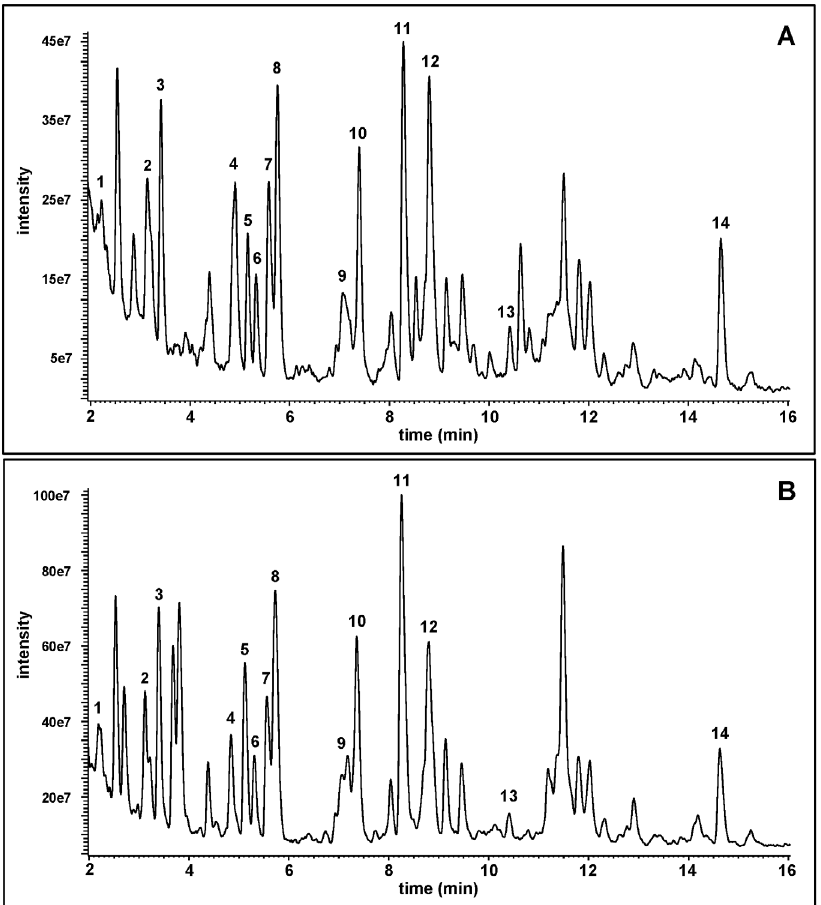
Figure 1. TIC profiles of the tryptic hydrolysates of hAPE1 (A) and 15 N-hAPE1 (B). The identities of the peptides are given in Table 1.